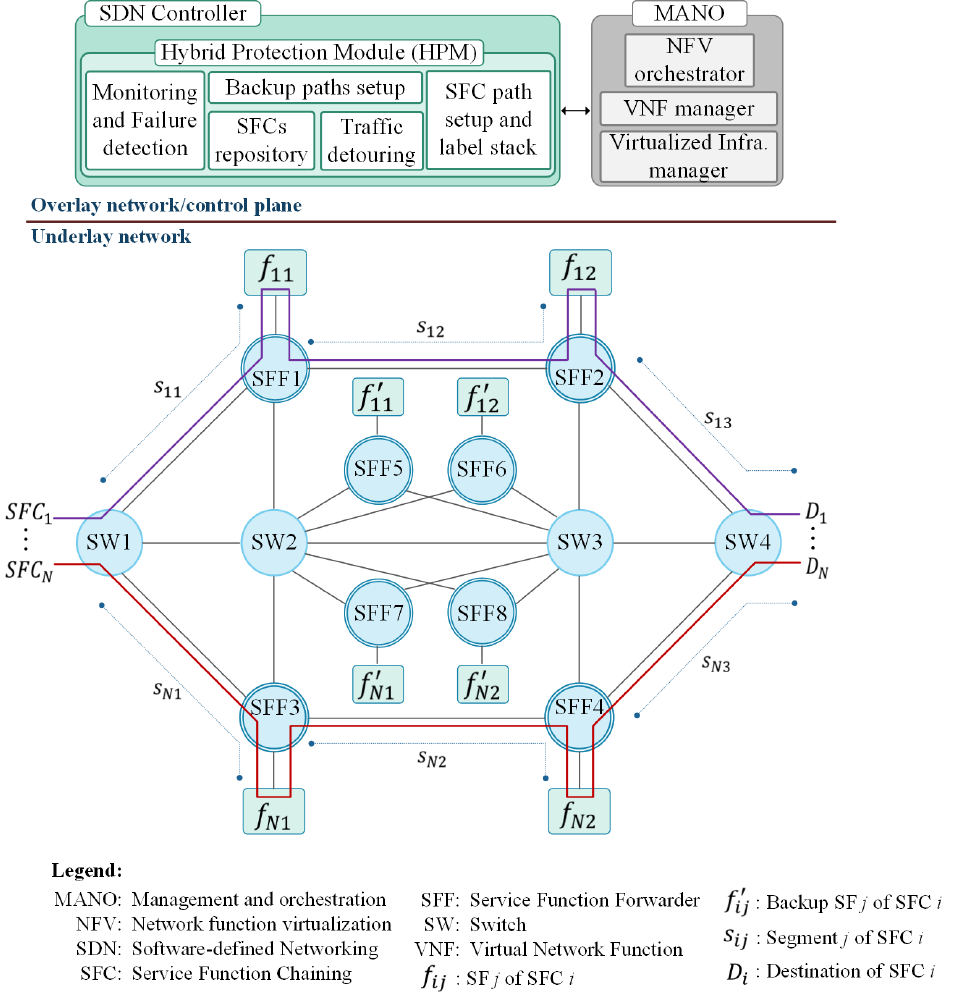
Figure 2. HP-SFC overlay and underlay networks’ architecture and system